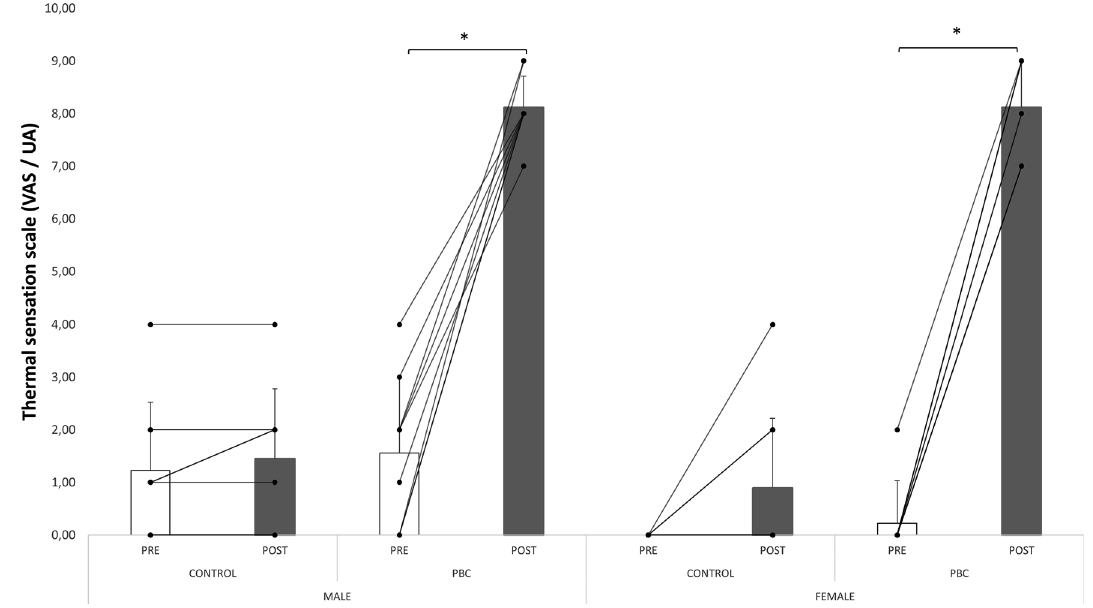
Figure 2. Cold sensation before and after experimental conditions. PBC partial body cryotherapy. *Significant ( P < 0.05).